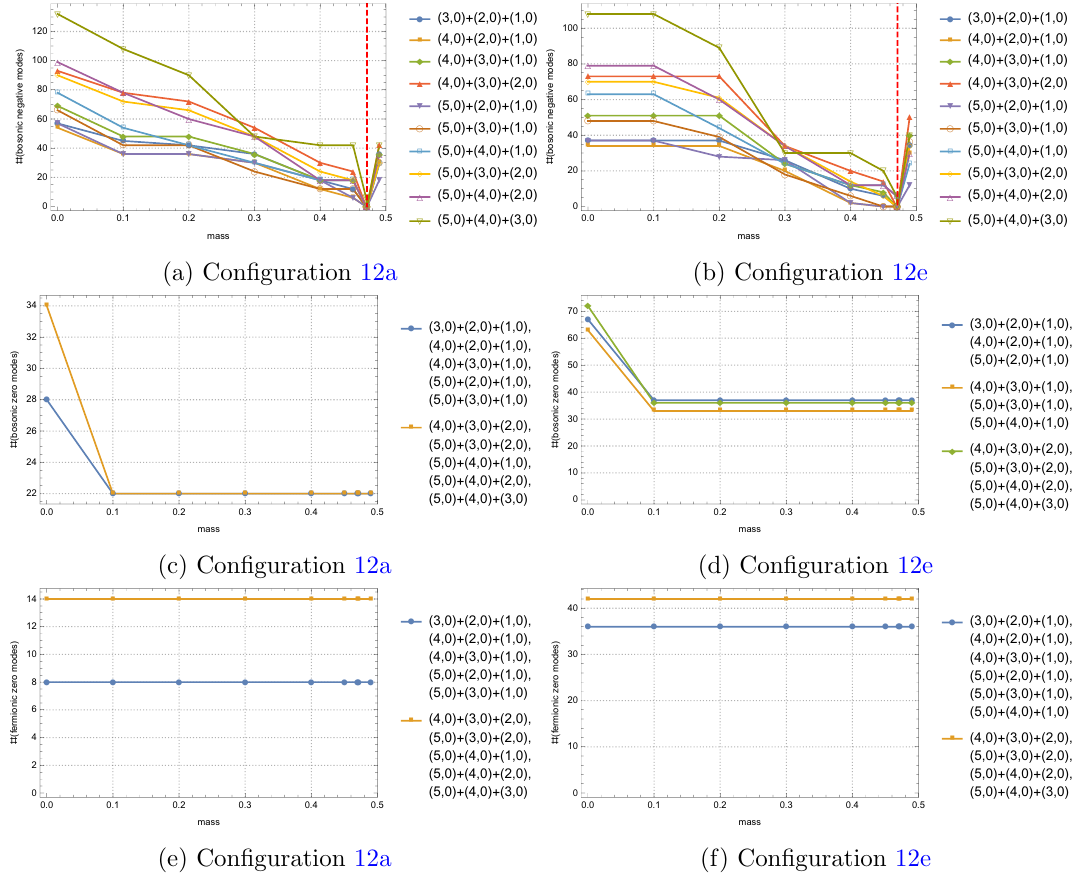
(d) Con(cid:12)guration 12e